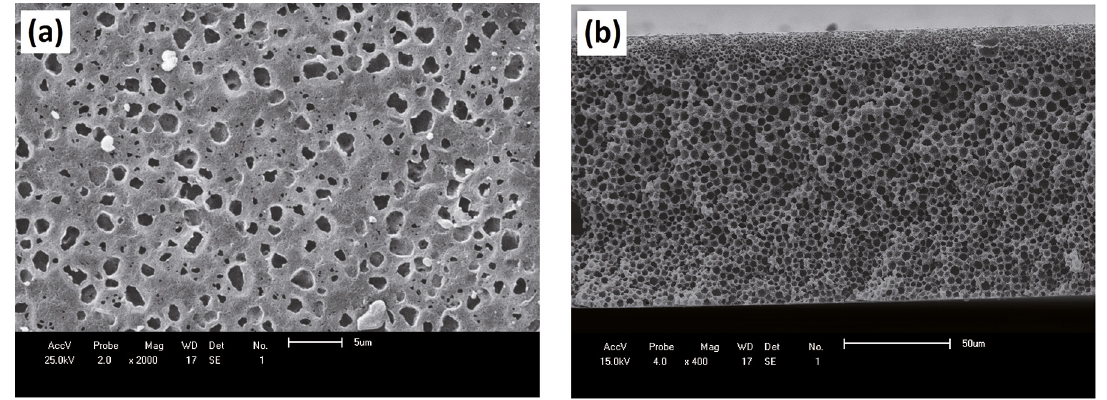
membrane: (a) top surface and (b) cross-section. 2